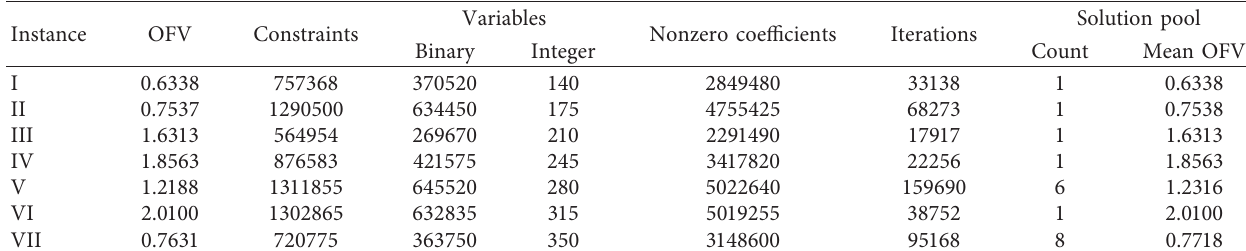
Table 6: The solving statistical information with BYCA-TSCS for the first stage by CPLEX.